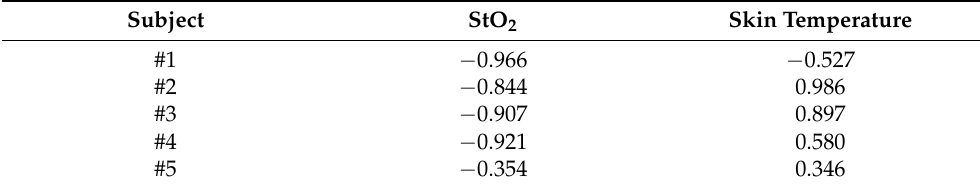
Table 5. Correlation coefficients between VAS and StO 2 as well as skin